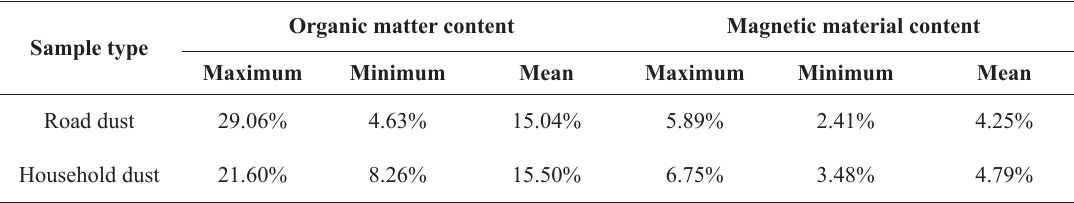
Table 3: Organic matter and magnetic material contents in the road and household dust.